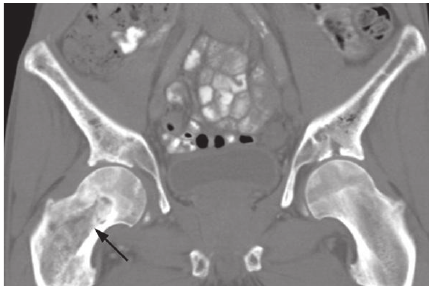
Figure 8: Coronal CT with oral contrast shows progression of bilateral femoral head osteonecrosis. There is also diffuse marrow signal abnormality of the visualized pelvis and right proximal femur (arrow), also believed to be consistent with osteonecrosis by